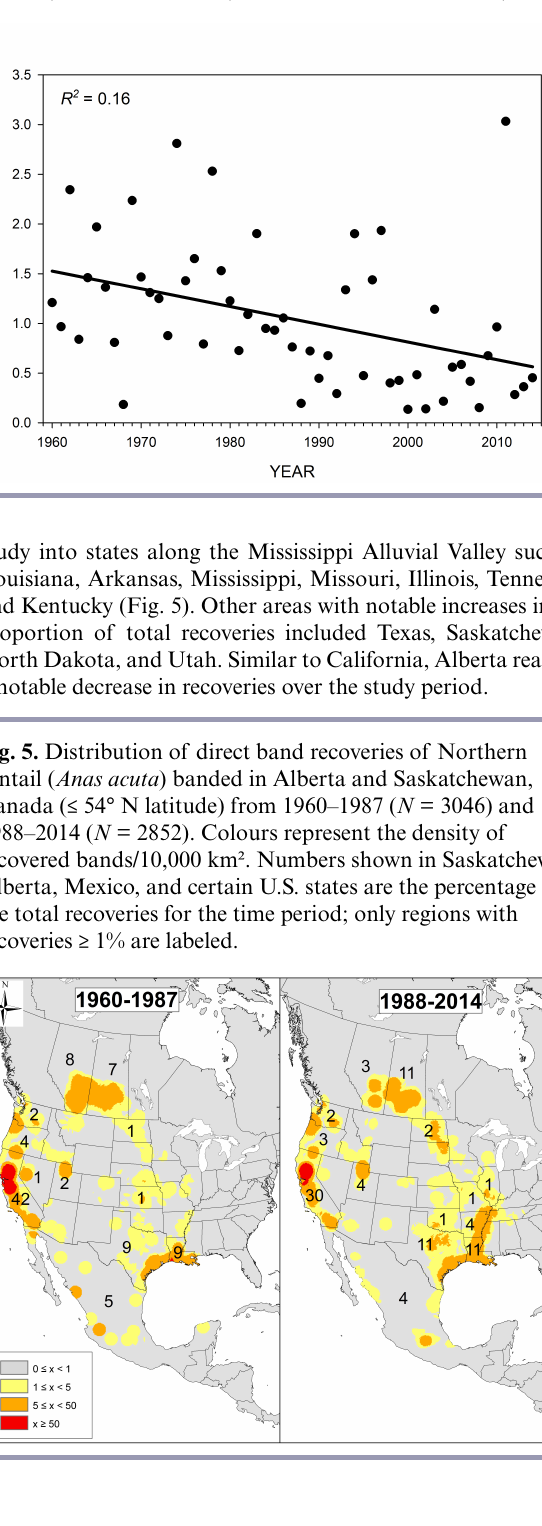
Fig. 4. Age ratio (hatch-year:adult) of Northern Pintail ( Anas acuta ) banded in Alberta and Saskatchewan, Canada (≤ 54° N latitude) from 1960–2014 ( r = −0.40, P = 0.002, N = 55).